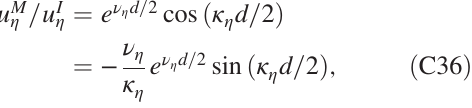
9. Spatial profiles of the TM modes in the cavity configuration at low and high in-plane momenta q . The black dashed vertical lines indicate the metal-insulator interfaces. The blue solid curve shows the spatial profile of the out-of-plane component ½ i u ⊥ η ð z Þ(cid:4) mode function (corresponding to the z component of the electric field). The red solid curve shows the spatial profile of the in-plane component ½ u ⊥ η ð z Þ(cid:4) of the mode function (corresponding to the x component of the electric field). The parameters are the same as in x Fig. 6, while the in-plane momentum q for low- and high-momentum results is chosen to be q ¼ 0 . 1 Ω =c and q ¼ 7 Ω =c ,